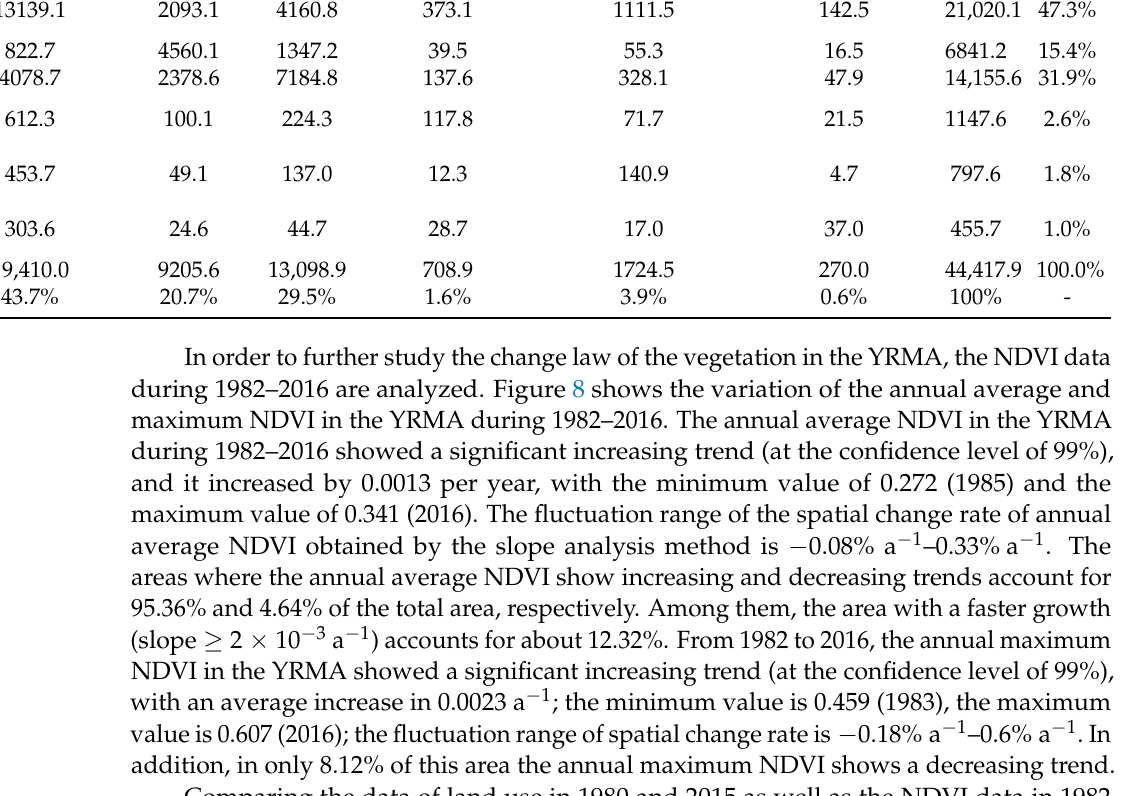
Table 4. Transfer matrix of land use types in the mountain area of Yongding River from 1980 to 2015 unit: km 2 . 2010 Cultivated Land Woodland Grassland Water Area Construction Land Unused Land Total P 1980